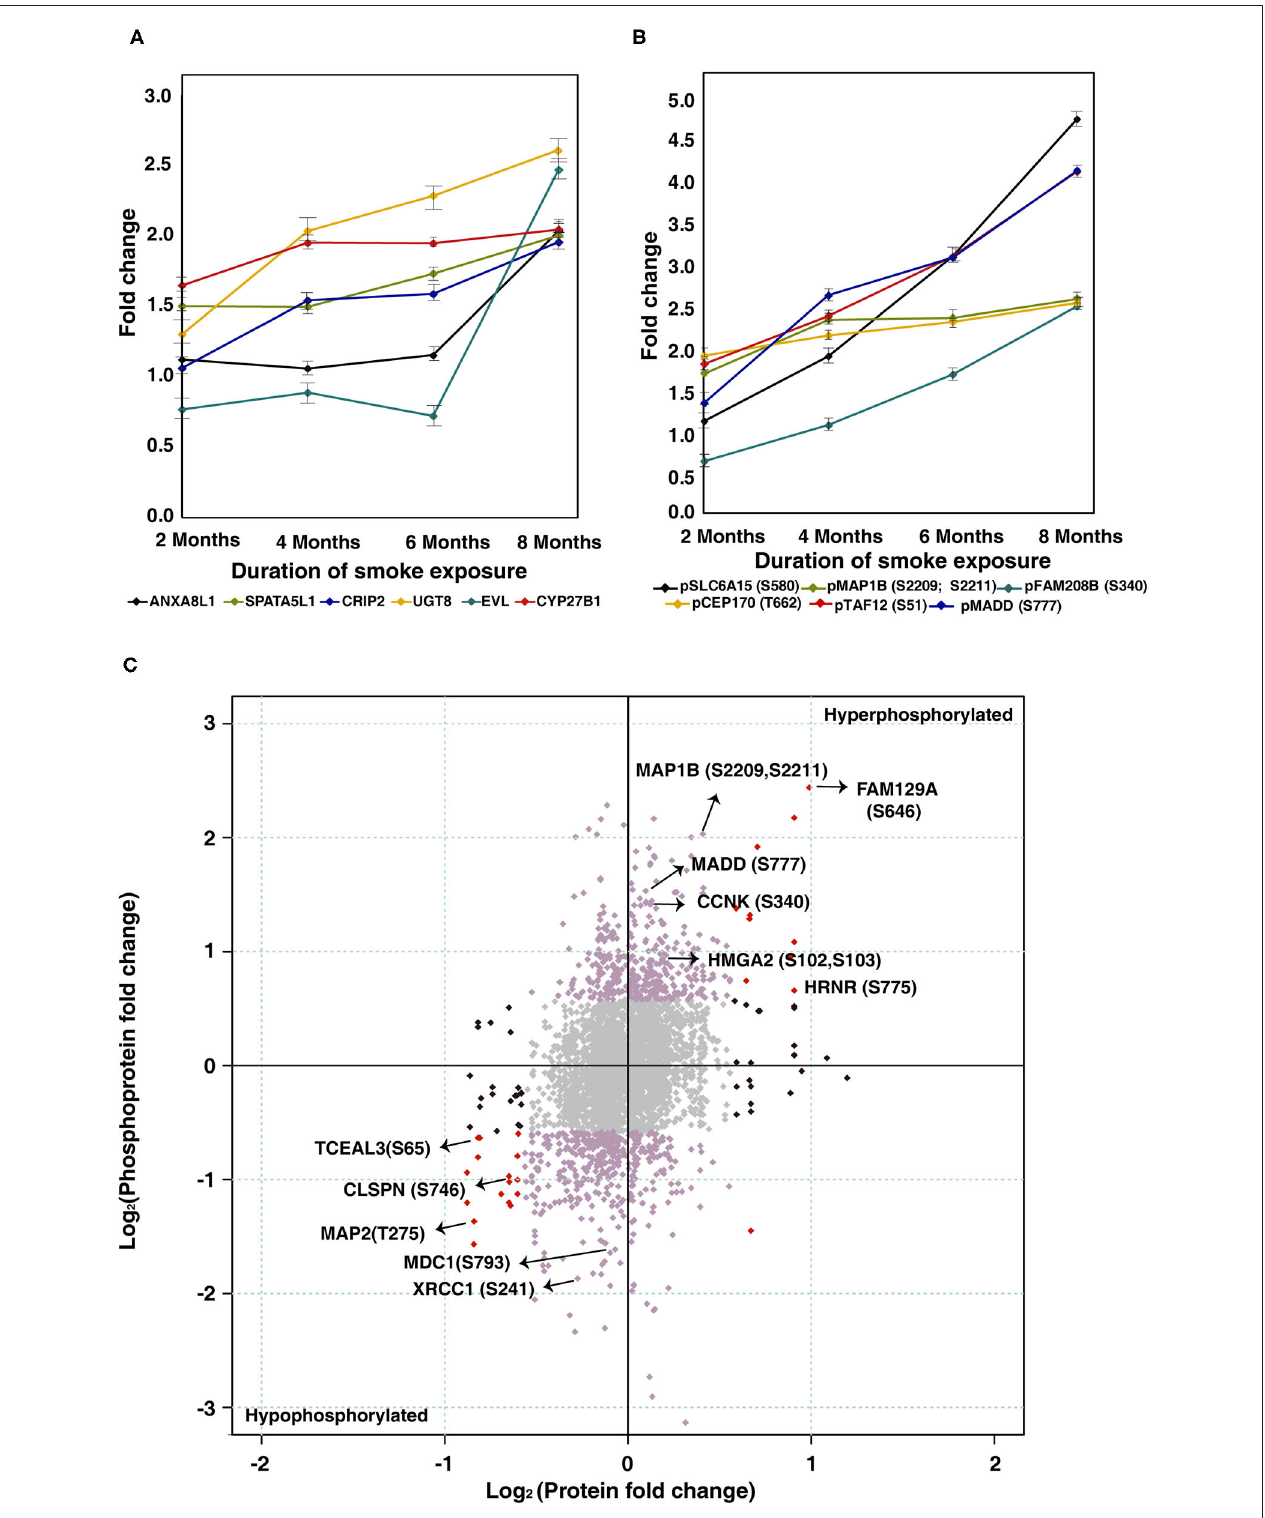
FIGURE 3 | Chronic treatment with cigarette smoke condensate alters cellular proteome of esophageal cells. (A) Expression profile of proteins that showed overexpression in CSC treated cells as a function of duration of exposure. (B) Expression profile of proteins that showed hyperphosphorylation in CSC treated cells as a function of duration of treatment. (C) Global representation of proteomic and phosphoproteomic data. Purple dots indicate differentially phosphorylated proteins that